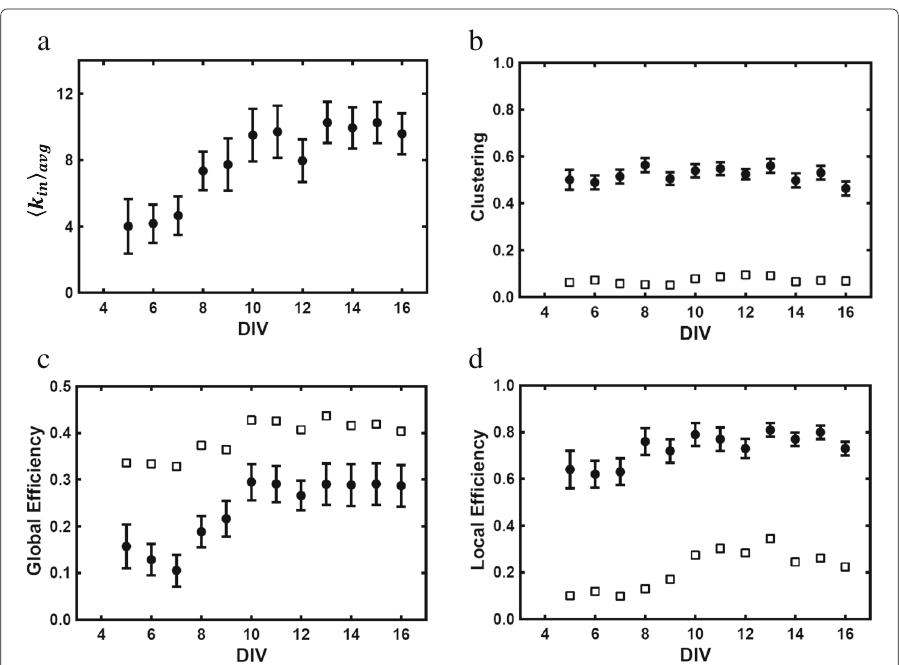
Fig. 7 Network properties. a Average in-degree, b clustering, c global efficiency, and d local efficiency as a function of neuronal age. Solidcircles : averages of all networks mapped for given day with error bars determined by the standard error of the mean (SEM). Opensquares : averages computed from a randomized network model having the same degree distribution as each mapped